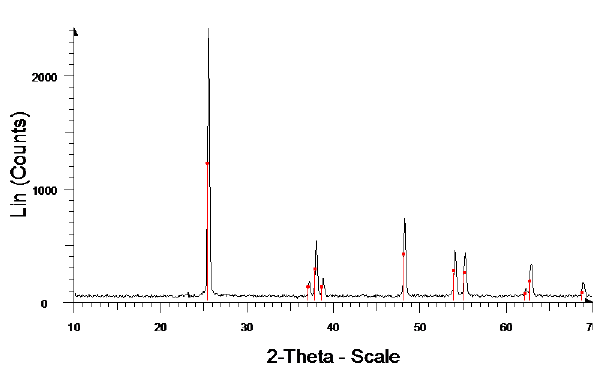
Fig. 3. Image of bulk TiO croscope (SEM)